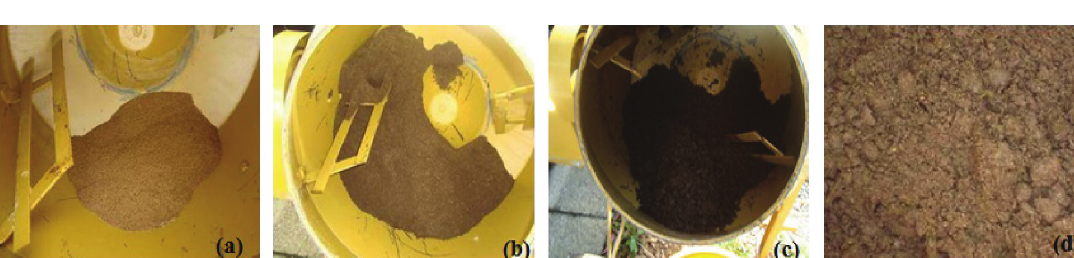
Figure 1. Simulated soil preparation: (a) grit sand, (b) grit sand and black earth, (c) grit sand, black earth and horse manure and (d) final aspect of simulated soil.